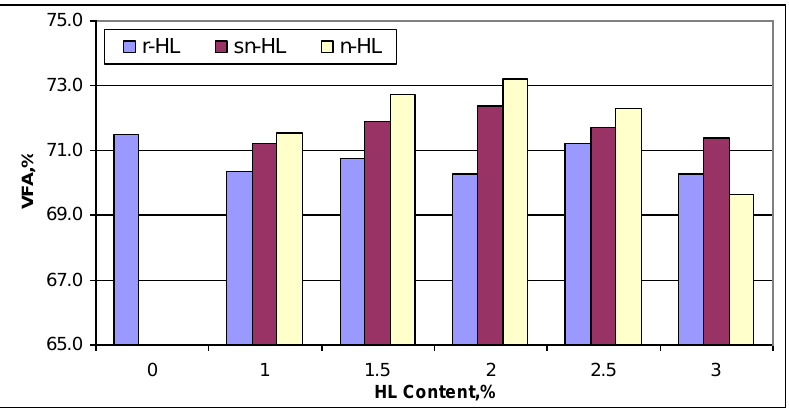
Figure 12. Comparison of VFA.